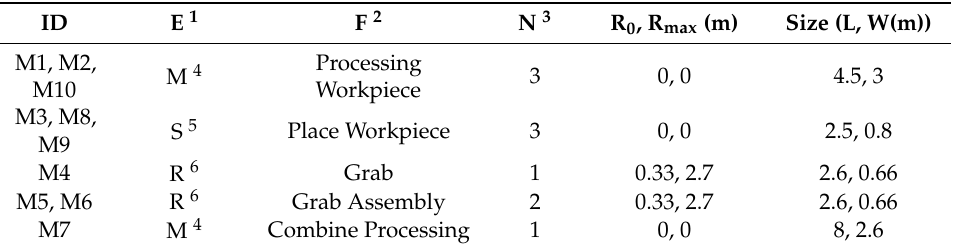
Table 4. Equipment Table 4. Equipment information.